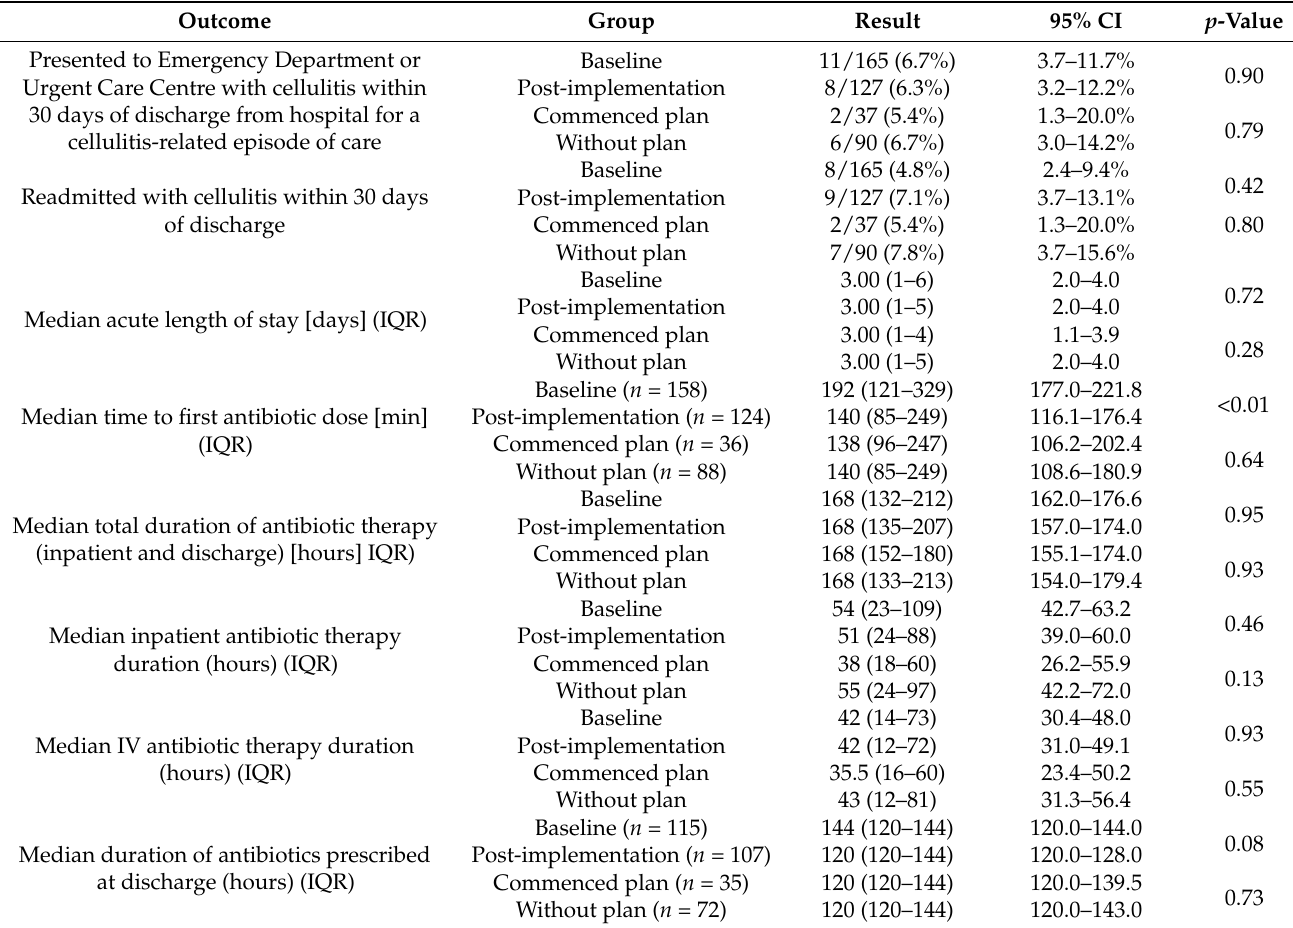
Table 4. Secondary outcome